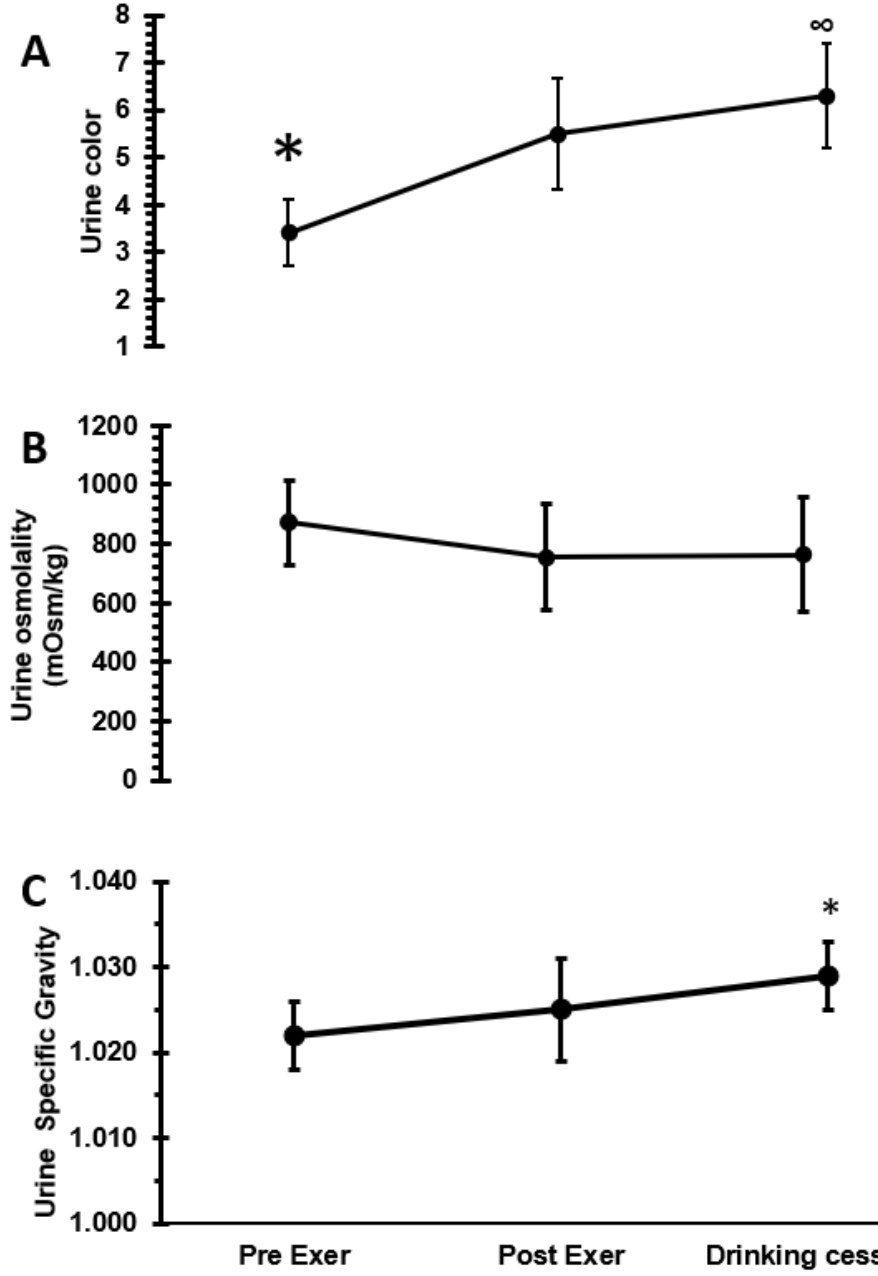
Figure 2. ( A ) ANOVA (F = 18.25, p < 0.0001) for urine color, * difference between pre- and post-exercise (dehydration) ( p = 0.0008), post-exer (dehydration) and drinking cessation ( p = 0.259), ∞ pre-exer and drinking cessation ( p < 0.0001). ( B ) ANOVA for urine osmolality. There was no effect of time (F = 1.62, p = 0.217). ( C ) ANOVA (F = 4.14, p = 0.028) for urine specific gravity. * Statistical difference between pre-exer and drinking cessation ( p =